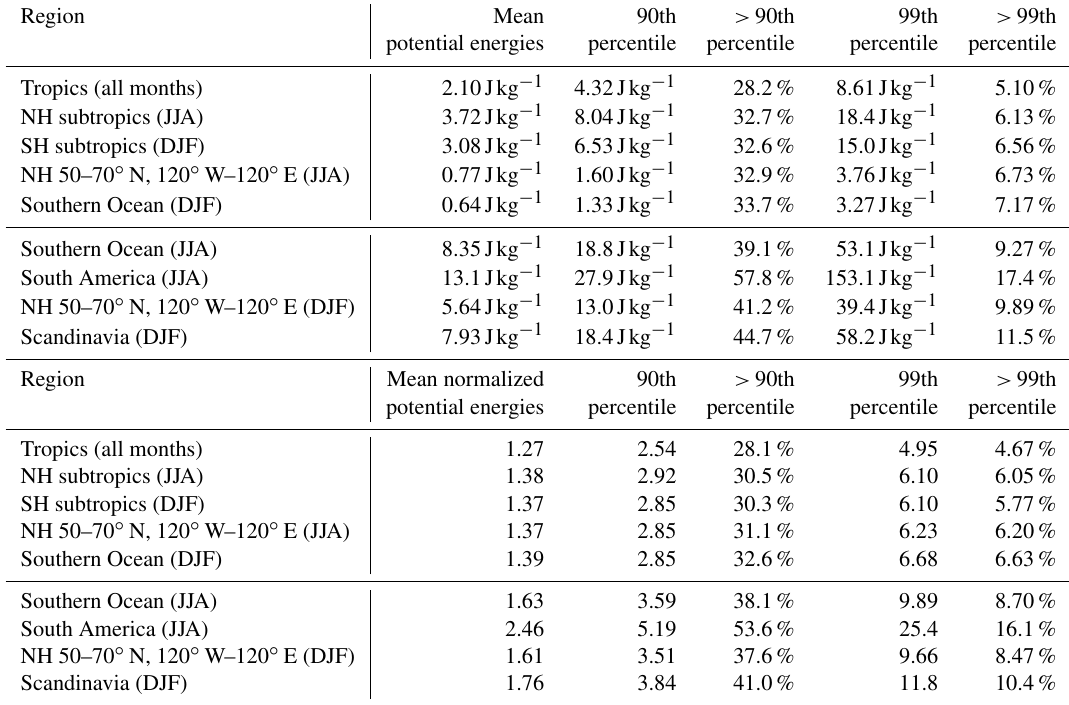
Table 4. Means, 90th percentiles, and 99th percentiles as well as fractions of gravity wave potential energies at values beyond the respective percentiles for the PDFs of potential energies (upper part of the table) and normalized potential energies (lower part of the table) shown in Figs. 9 and